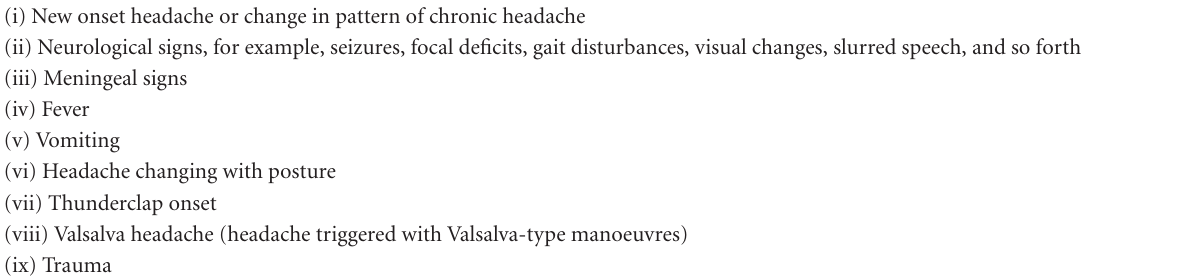
Table 3: Warning signs and symptoms—“ New